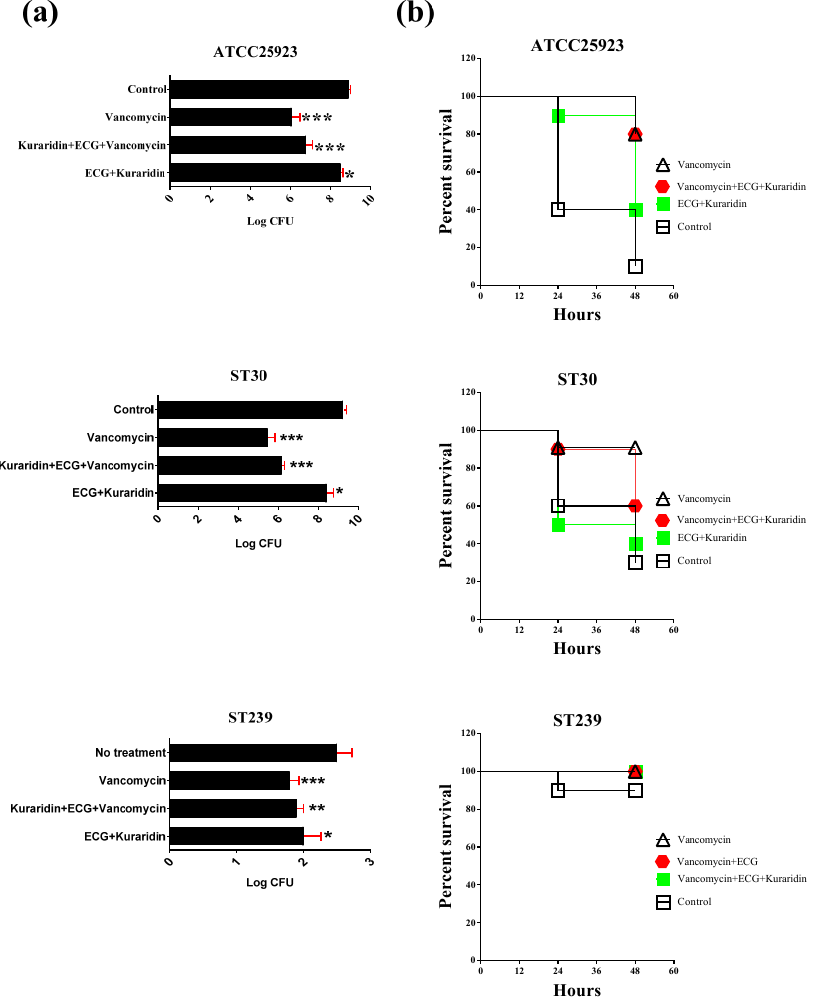
Figure 3. Mice infected with ATCC25923, ST239, or ST30 (3 × 10 8 colony forming unit (CFU)) with different treatment options. Mice were sacrificed after 48 h. ( a ) The bacteria counts in Log CFU recovered from the left lungs; ( b ) the survival rates of each treatment group. Significant results by comparing the drug treatment groups with the drug free control are indicated (* p < 0.05; ** p < 0.01; *** p < 0.001) (n = 10).